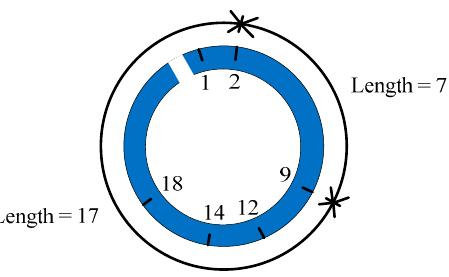
Figure 4. A length-24 circular sparse ruler.